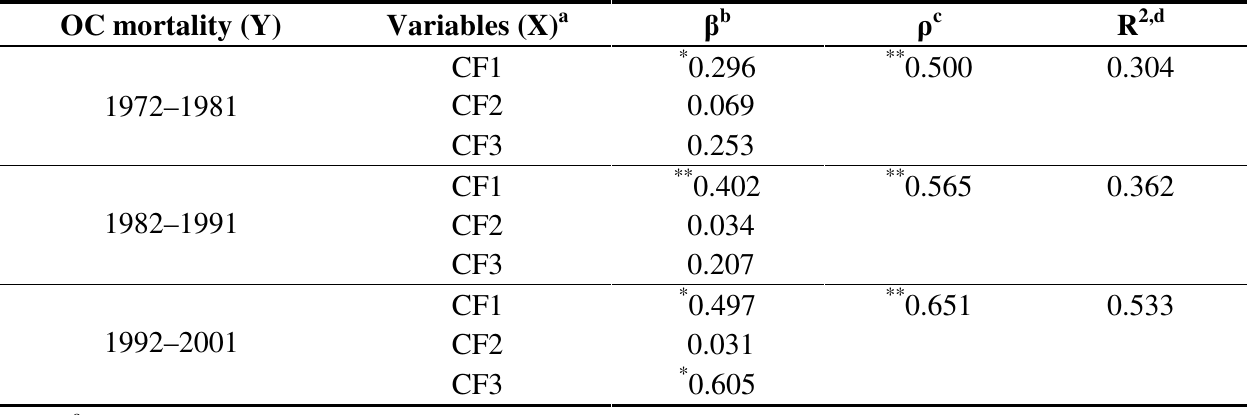
Table 3. Estimations of spatial lag models (SLM) for male OC mortality